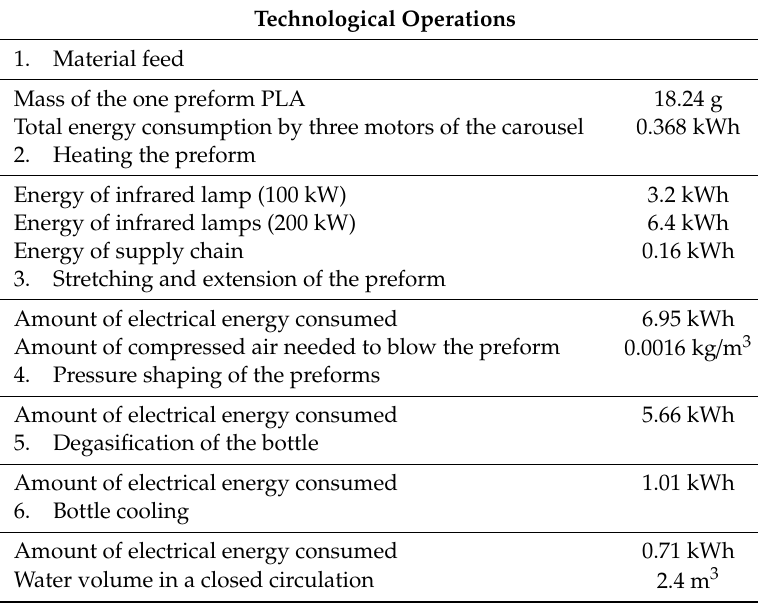
Table 1. Results LCI [23].